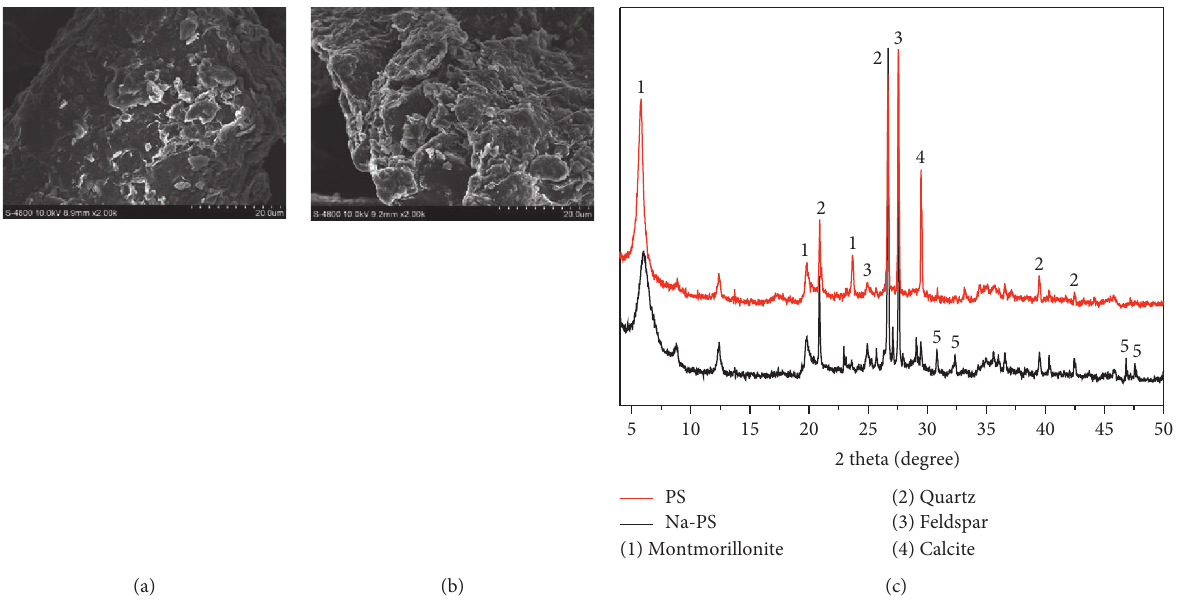
Figure 1: Scanning electron microscope images of PS (a) and Na-PS (b) and XRD patterns (c). Note: PS means Pisha sandstone; Na-PS means Pisha sandstone modified with Na +